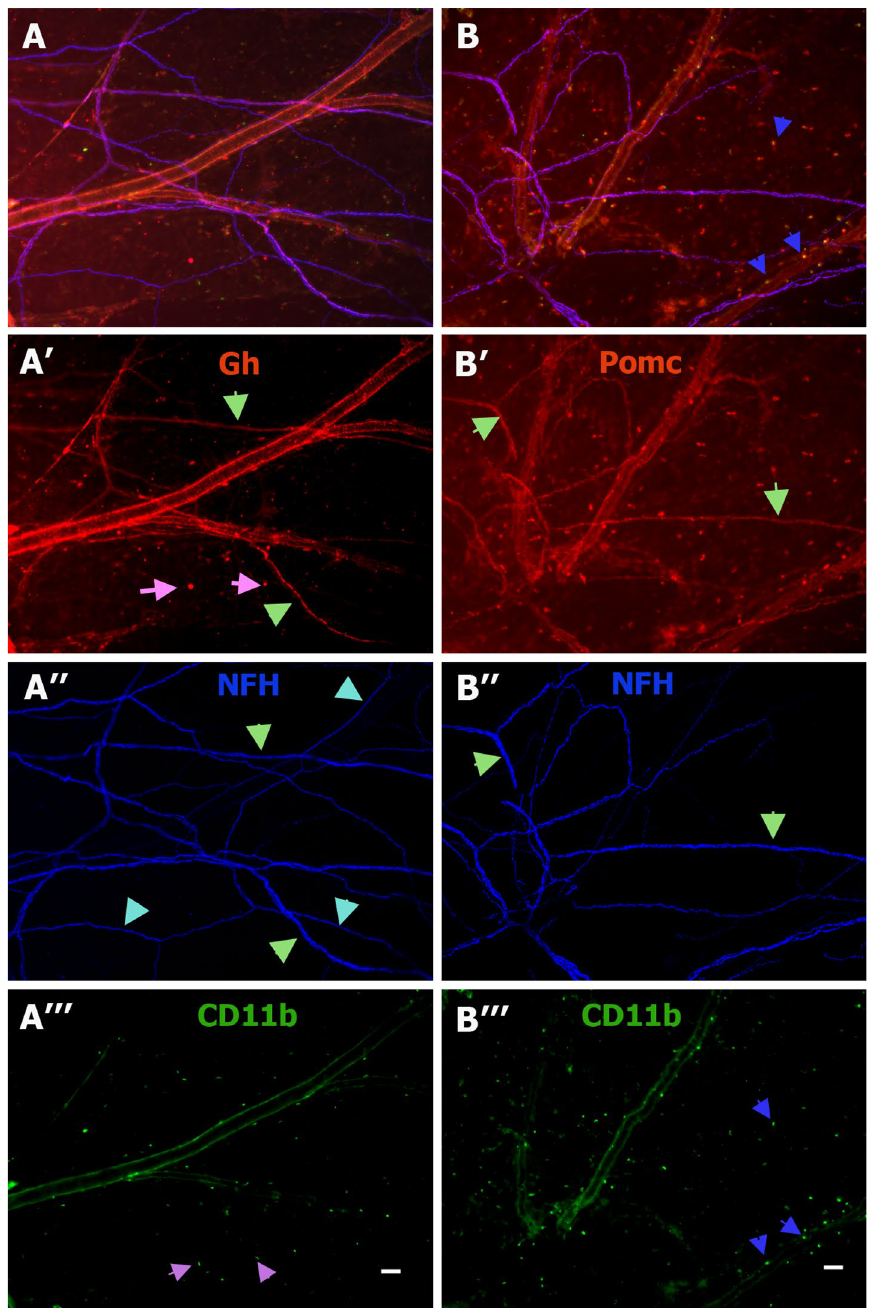
Figure 6. Expression of GH and Pomc in male mouse dura mater. IHC on naïve male mouse dura matter with Gh (red), NFH (blue) and CD11b (green) ( A ), Gh ( A’ ), NFH ( A’’ ) and CD11b ( A’’’ ) antibodies. Green arrows show Gh + /NFH + nerve fibers ( panels A’ and A’’ ). Cyan arrows show Gh - /NFH + nerve fibers ( panels A’ and A’’ ). Pink arrows show Gh - /CD11b + cells ( panel A’’’ ). IHC on male mouse dura matter with Pomc (red), NFH (blue) and CD11b (green) ( B ), Pomc ( B’ ), NFH ( B’’ ) and CD11b ( B’’’ ) antibodies. Green arrows show Pomc + /NFH + nerve fibers ( panels B’ and B’’ ). Blue arrows show Pomc + /CD11b + cells ( panels B and B’’’ ). Images were captured with × 10 objective. Bar on panels A’’’ and B’’’ correspond to 30